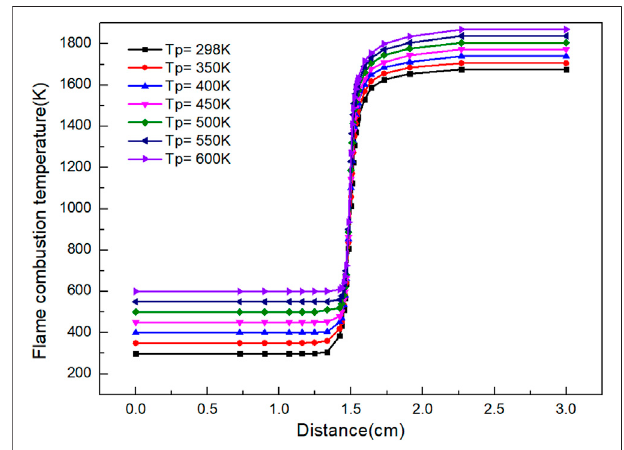
FIGURE 1 | Graph of fl ame combustion temperature versus fl ame distance with variation of preheating